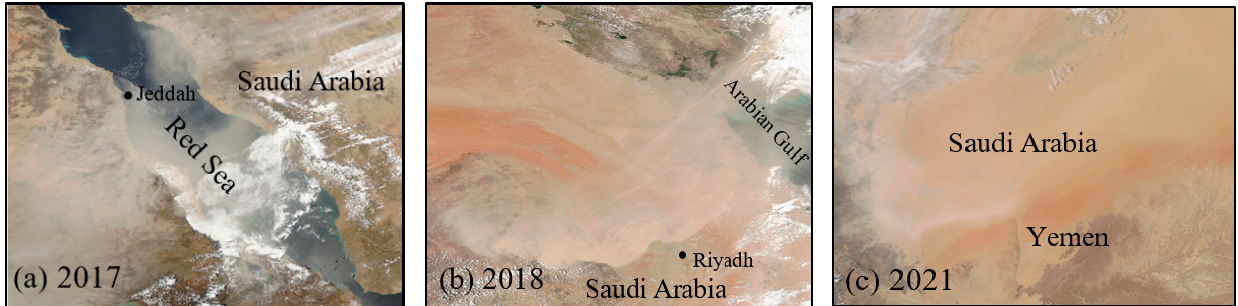
Figure 2. Major dust storms blown over Saudi Arabia on ( a ) 20 March 2017, ( b ) 23 April 2018, and ( c ) 15 April